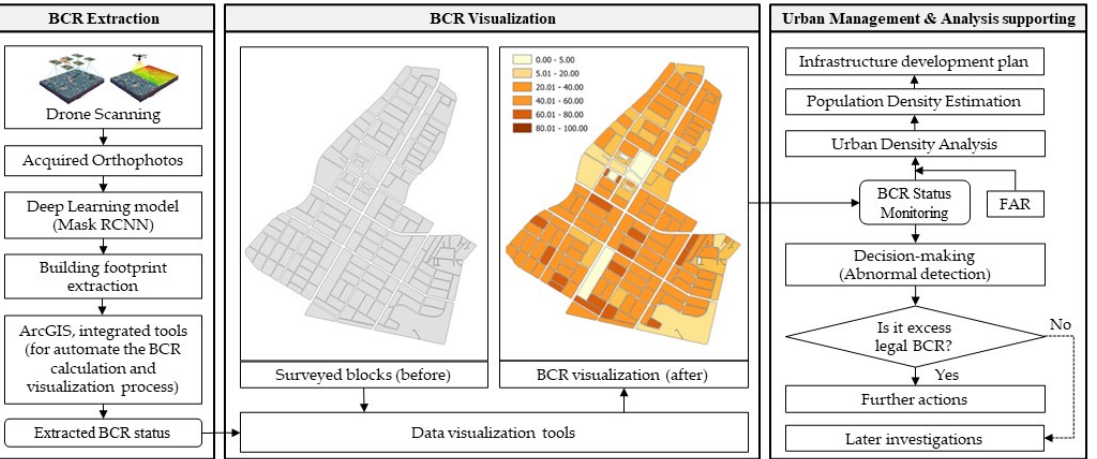
Figure 8. Proposed applications of the new BCR calculation approach based on DL for urban management and urban density analyses.